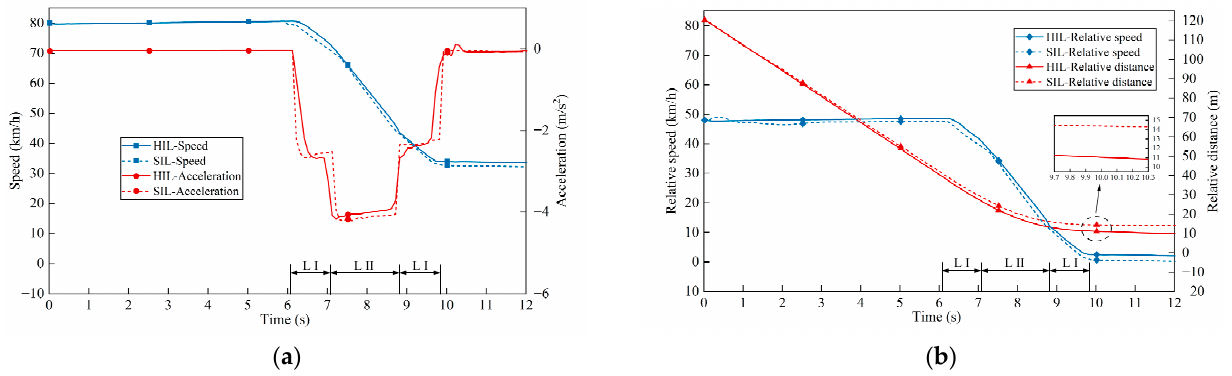
Figure 11. HIL testing and SIL testing results of CCRm condition: ( a ) speed of VUT and acceleration of VUT; ( b ) relative speed and relative distance.